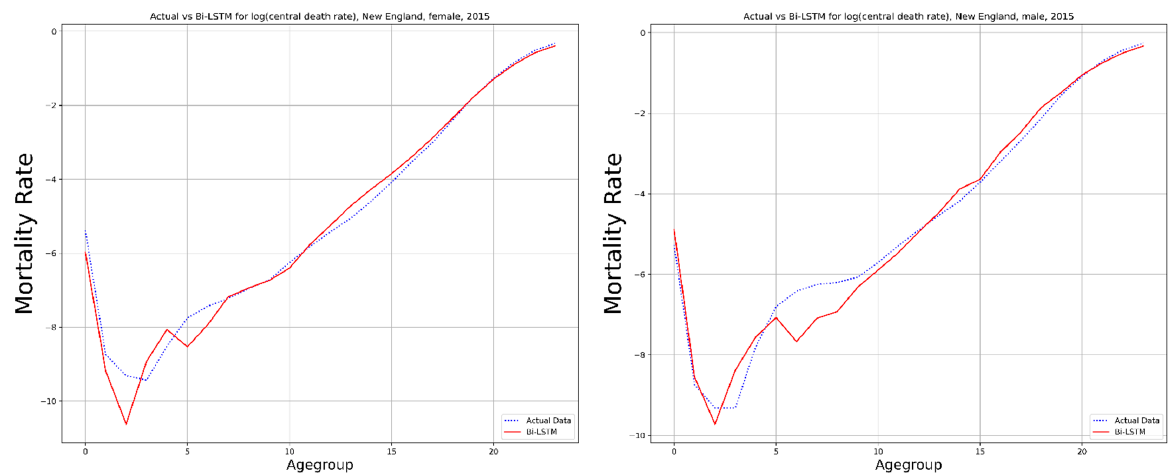
Figure 11. The predictions of the log-mortality rate for New England female ( left ) and male ( right ), 2015: LSTM (red) vs. real (blue).